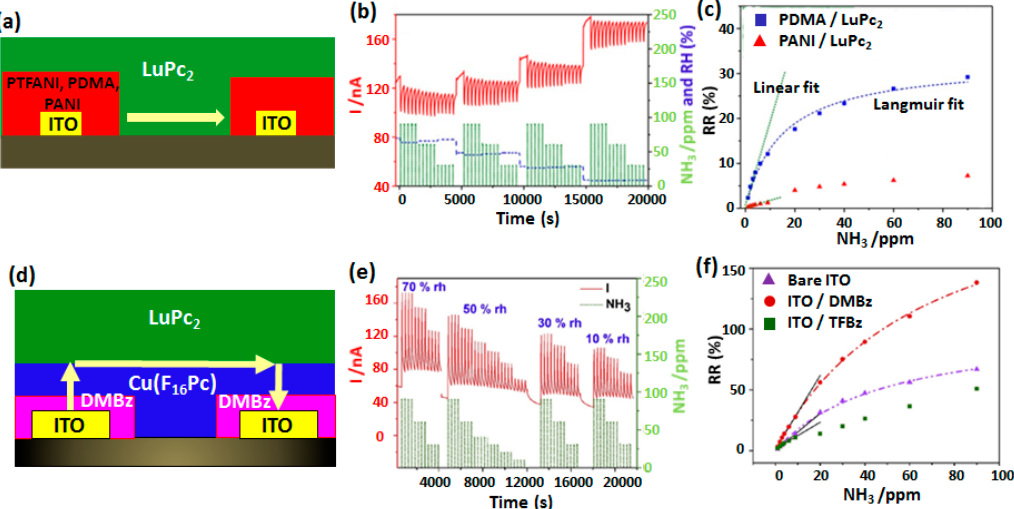
Figure 15. Scheme of Double Lateral Heterojunction of an electropolymerized (PTFANI, PDMA, PANI) organic film on ITO electrodes and PVD coated LuPc 2 over it ( a ). Change in PTFANI DLH current at di ff erent NH 3 concentrations (10–90 ppm) and rh (10–70%) ( b ). The variation in RR as a function of NH 3 concentration in a range of 1–90 ppm ( c ) [15,63]. Scheme of DMBz (from DMA precursor) modified Cu(F 16 Pc) / LuPc 2 MSDI on ITO electrodes ( d ) and its current variation at di ff erent NH 3 concentration (10–90 ppm) and rh (10–70%) ( e ). Calibration curve (RR vs NH 3 concentration) of